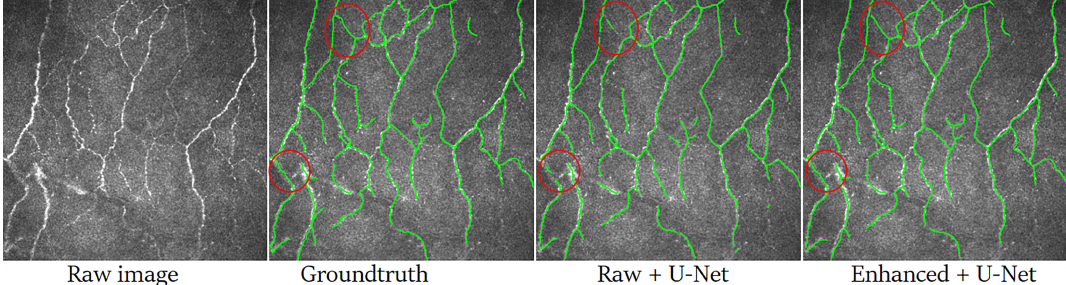
Figure 7. Comparison of nerve fiber segmentation results between raw image and our enhanced image with